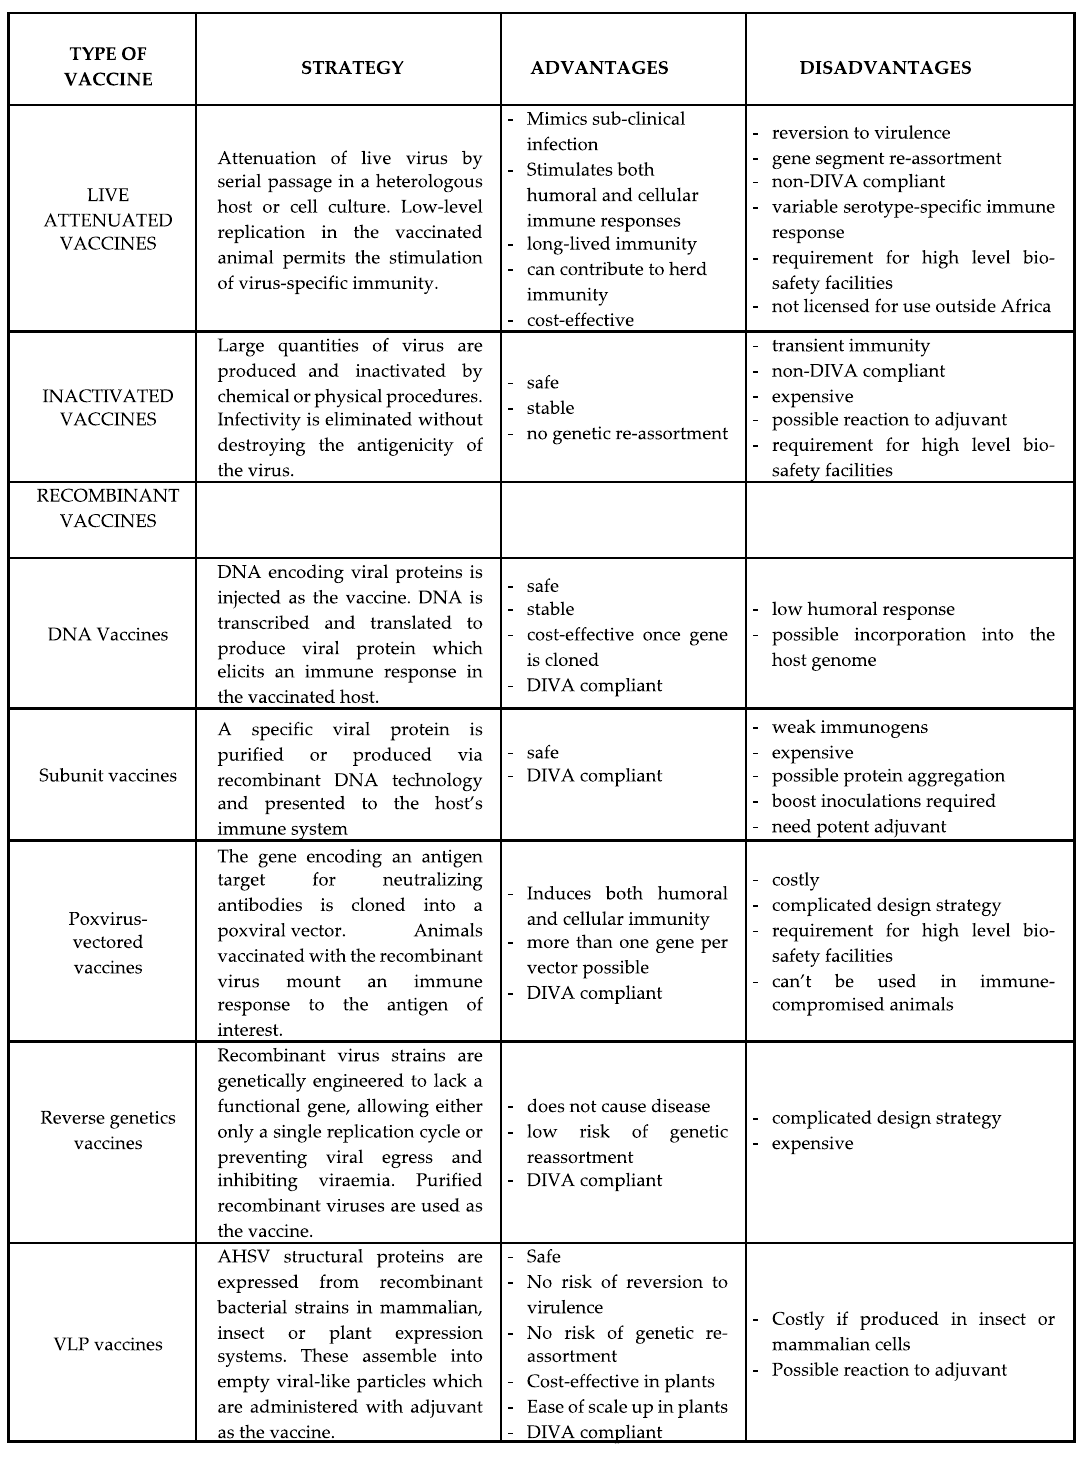
Figure 4. A summary of the various vaccine strategies against African horse Figure 4. The various vaccine strategies against African horse sickness, together with the advantages and disadvantages of each, are summarized above.